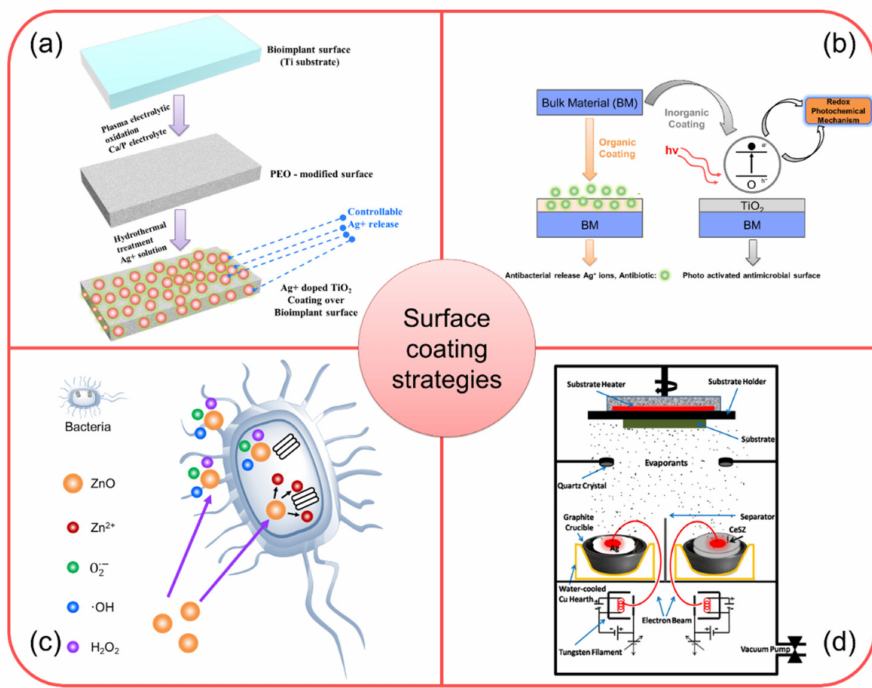
Figure 4. ( a ) Schematic demonstrating stepwise fabrication of antibacterial responsive coating of Ag + doped TiO 2 [121]; ( b ) Schematic showing the deposition and antibacterial action of TiO 2 coated bioimplant via redox photochemical method [123]; ( c ) Schematic illustration of antibacterial response of ZnO-based nanomaterial coating [118]; ( d ) Schematic showing ion beam assisted coating of antibacterial Ag-CeSZ-based nanomaterial coating [120]. Adapted with permission from [118]; 2018 ACS Publications; Adapted with permission from [120]; 2019 Elsevier; Adapted with permission from [123]; 2011 SAGE